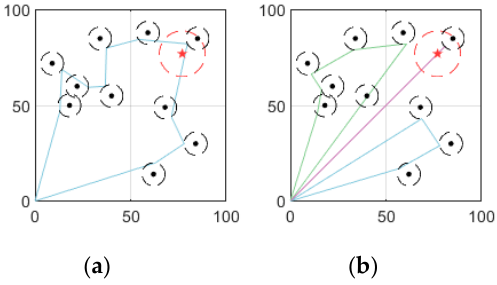
Table 5. The typical objective values .